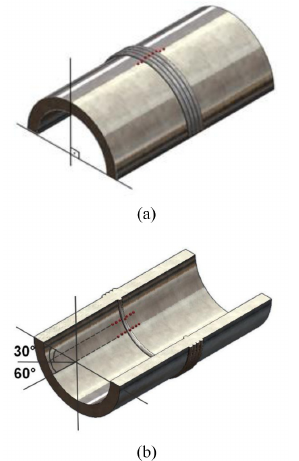
Figure 2. Schematic representation of welded half-pipe showing location (red point and angles) of residual stresses measurement (a) on the cap; (b) on the root.